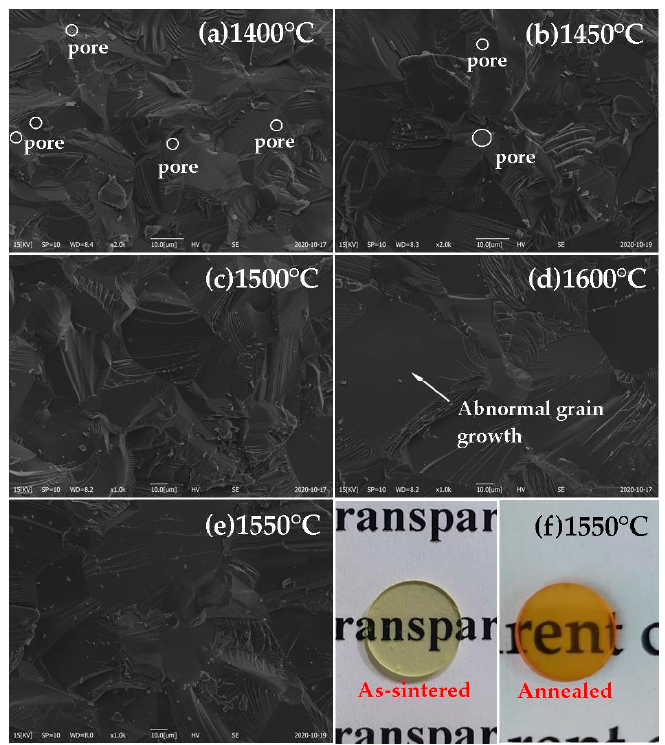
Figure 3. SEM micrographs of the fracture surface of (Dy 0.7 Y 0.25 La 0.05 ) 2 O 3 ceramics:( a ) 1400 °C/6 h; ( b ) 1450 °C/6 h; ( c ) 1500 °C/6 h; ( d ) 1600 °C/6 h; ( e ) 1550 °C/6 h; ( f ) the appearance of the (Dy 0.7 Y 0.25 La 0.05 ) 2 O 3 transparent ceramics sintered at 1550 °C: as-sintered and annealed at 900 °C for 5 h in air.